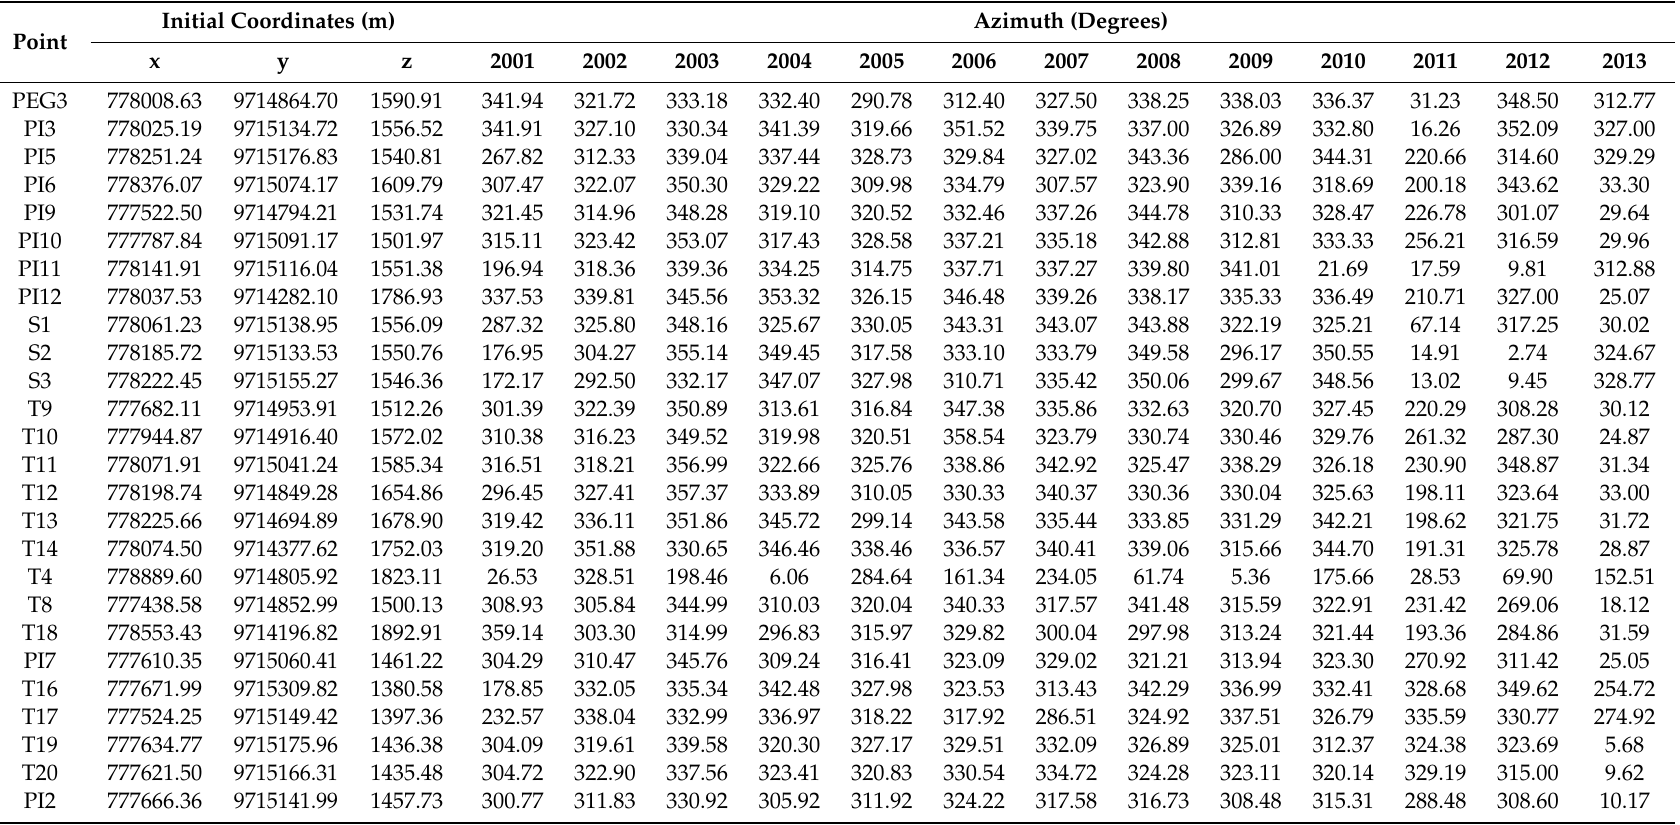
Table A3. The initial coordinates and azimuth of movement detected by 26 fixed points in Guarumales from 2001 to